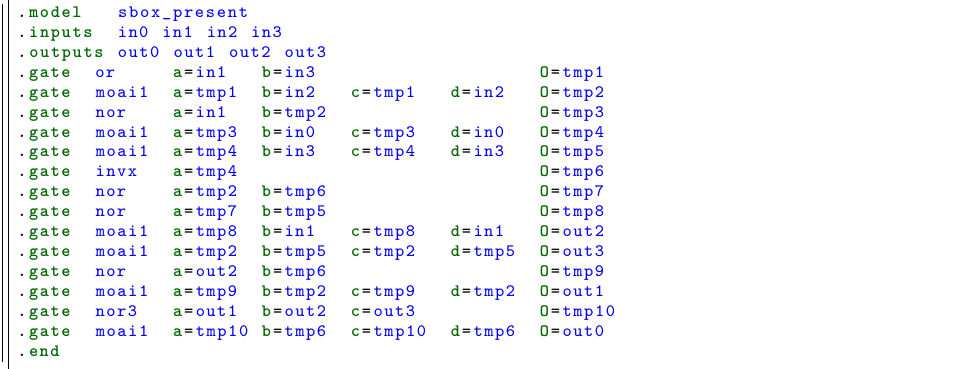
Figure 7: Area-optimized hardware implementation of PRESENT Sbox using 21.33 GE with the standard cell library of the UMC 180nm logic